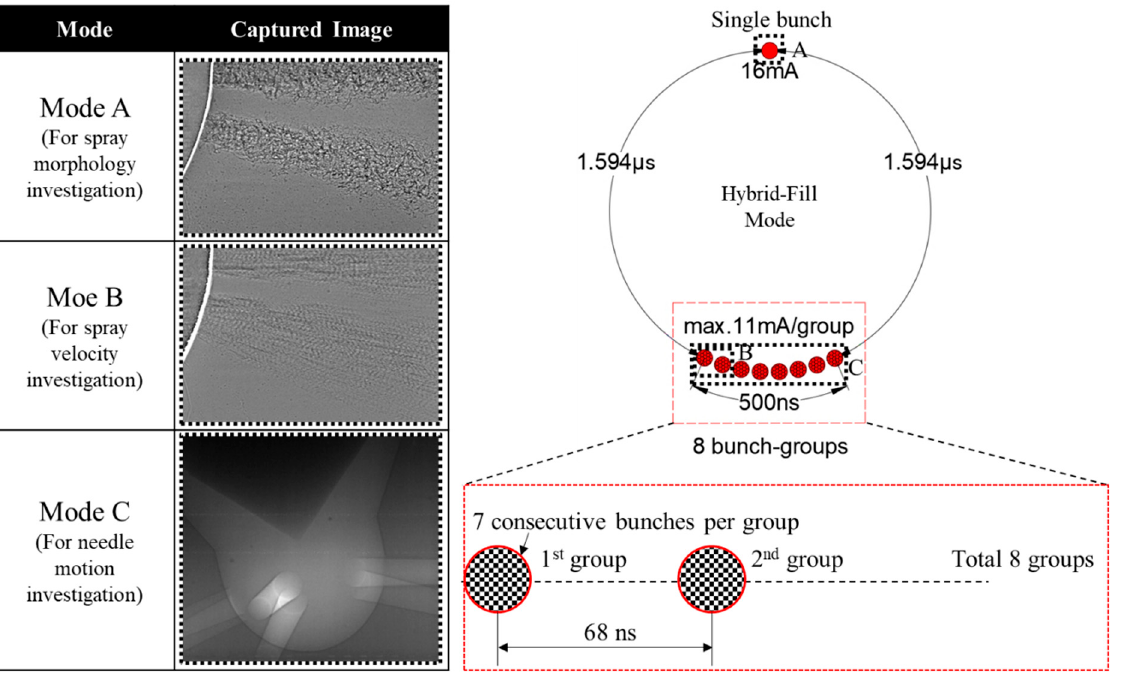
Figure 1. X-ray pulse timing patterns and modes used for single-exposure spray imaging, double- exposure spray imaging, and needle motion